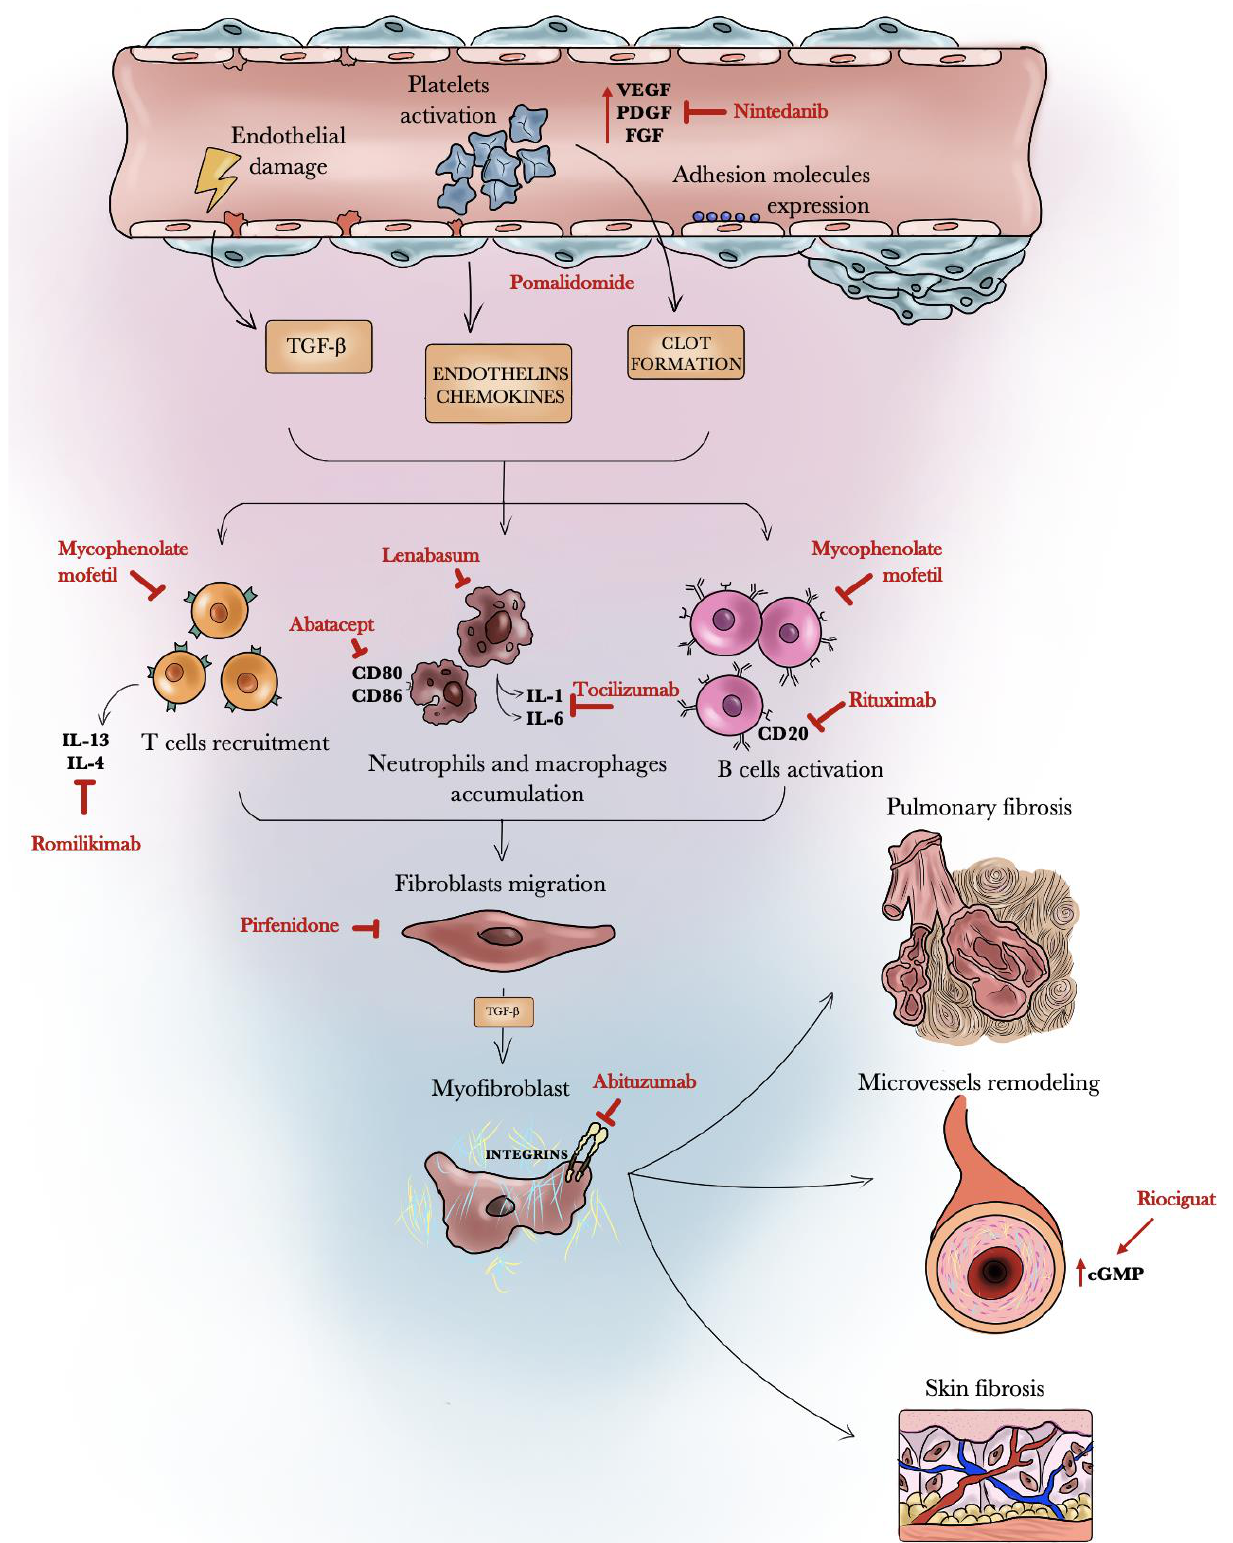
Figure 1. Schematic representation of the mechanism of action of nintedanib, pomalidomide, tocilizumab, rituximab, romilikimab, pirfenidone, lenabasum, and riociguat.